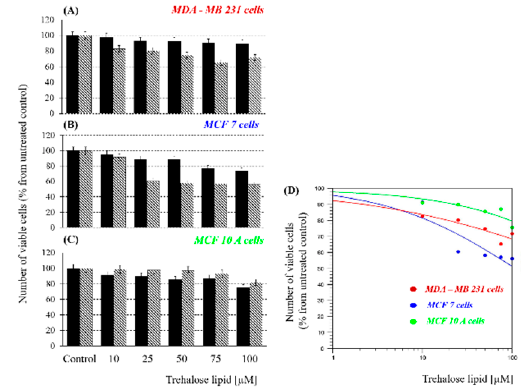
Figure 1. Number of viable cells after treatment with trehalose lipids (TL) at different concentrations (10, 25, 50, 75, 100 μ M), presented as a percentage of control (untreated) cells, analyzed by MTT assay. Presented in ( A – C ) results are respectively for: MDA–MB23, MCF7 cancer cells, and normal MCF10A cell line; black solid columns present data after 24 h incubation and the striped columns after 48 h. All data are means ±SD from three independent experiments. Statistical analysis: (i) All results are statistically significant versus controls at corresponding incubation time ( p -value <0.05); (ii) All presented data from 24 h are statistically significant versus data from 48 h ( p -value <0.01); (iii) Cancer lines versus Normal cells: all variations between data in ( A ) are significant versus data in ( C ): p -value <0.001 for both 24/24 and 48/48 h type comparison; all variations between data in ( B ) are significant versus data in ( C ): p -value <0.05 for 24/24 h and p -value <0.01 for 48/48 h comparison. (iv) Data from cancer cell lines’ comparison were calculated also as a statistically significant result ( p -value <0.01 for both 24/24 and 48/48 h variations). ( D ) GraphPad data calculation of the half-maximal inhibitory concentration (IC 50 )—number of viable cells 48 h after treatment with TL in different concentrations, as a percentage of control (untreated) cells. Values are means ±SD from at least three independent experiments at triplet repetitions.